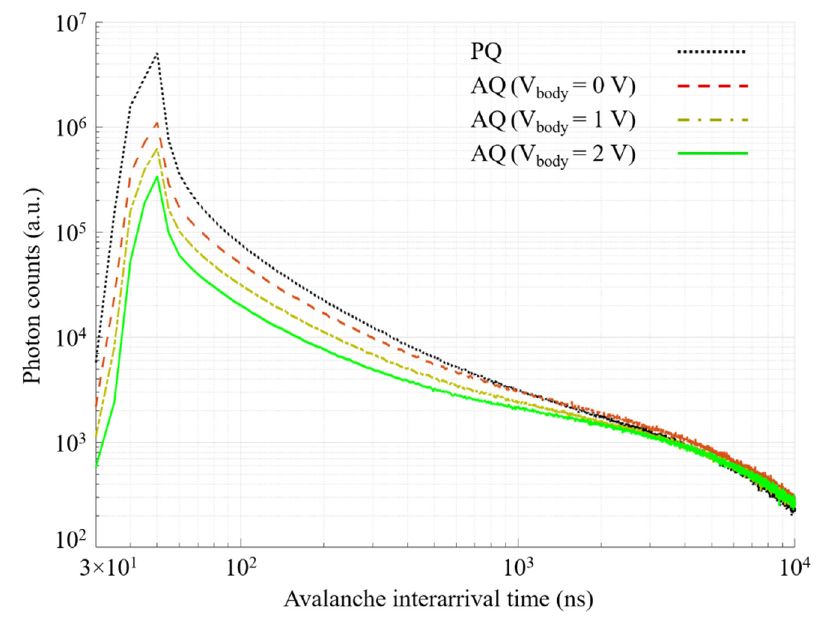
Figure 11. Avalanche interarrival time histogram in the PQ and the AQ for a hold off time of 5 ns. The excess bias voltage is 400 mV.